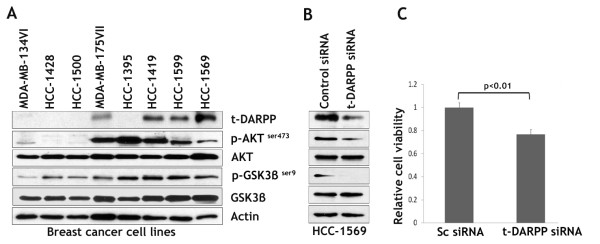
t-DARPP expression directly correlates with activation of AKT pathway in breast cancer cell lines, and knockdown of endogenous t-DARPP suppresses cell growth. A, Protein extracts from a panel of 8 breast cancer cell lines were subjected to western blot analysis of t-DARPP, p-AKTser473, AKT, p-GSK3βser9, GSK3β, and β-actin. 10 μg of total protein per lane were resolved on 10% SDS-PAGE and transferred onto Hybond-P PVDF membranes for immunodetection with the corresponding specific antibodies. B&C, HCC-1569 cells were transfected with control scrambled siRNA or t-DARPP siRNA oligonucleotides and grown for 48 h. Protein extracts were subjected to western blot analysis of t-DARPP, p-AKTser473, AKT, p-GSK3βser9, and GSK3β (panel B). Knockdown of t-DARPP in HCC-1569 cells led to down-regulation of the AKT signaling pathway as indicated by a significant decrease of p-AKTser473 and p-GSK3βser9 protein levels. The cells were subjected to Cell-Titer-Glo Luminescent Cell Viability Assay. Overall, cell growth was significantly lower in HCC-1569 cells transfected with t-DARPP siRNA than control cells (panel C). Results are representative of three experiments and shown as the mean ± SD. Significance of difference was calculated using Student's t test analysis.